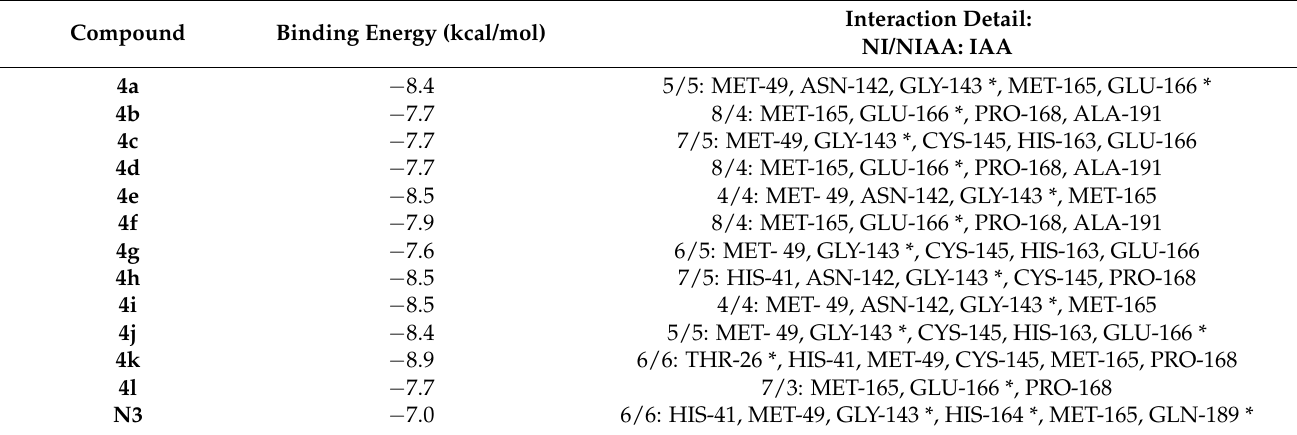
NI: number of interactions, NIAA: number of interacting amino acids, IAA: interacting amino acids, * = One hydrogen